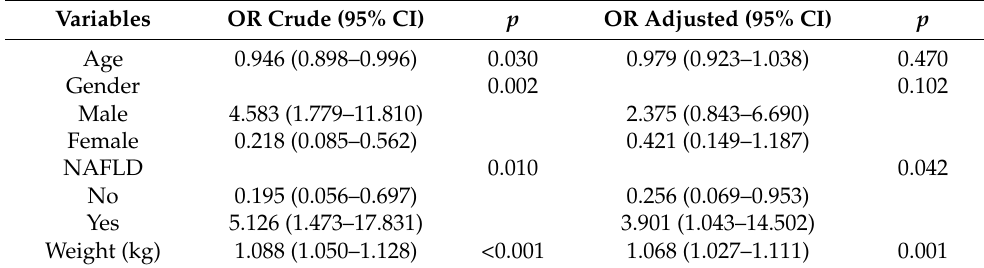
Table 3. Odds ratios of presenting hyperfiltration (eGFR > 120 mL/min) in patients with MetS.